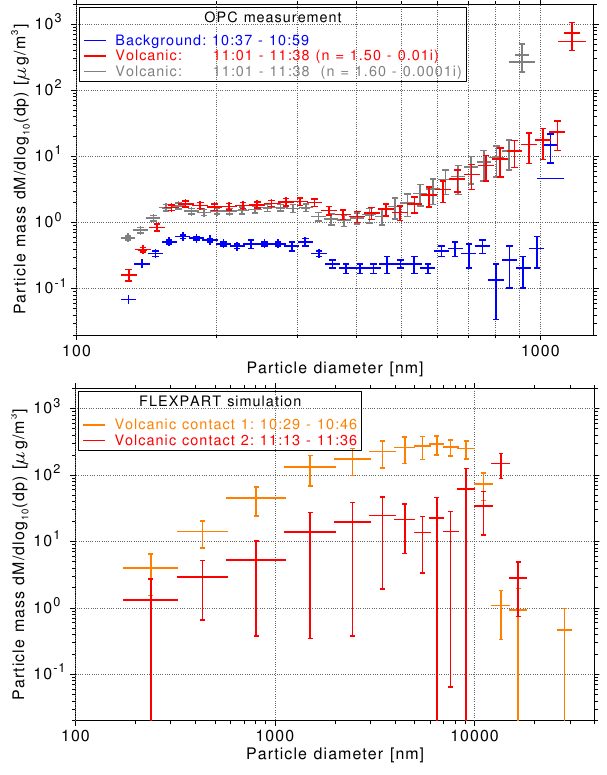
Fig. 8. Measured and modelled particle mass size distributions for the CARIBIC flight on 19 May 2010. Upper panel: measured OPC size distributions. Shown are averaged distributions for the back- ground aerosols (blue) and for the volcanic ash cloud (red & gray). Error bars indicate the 1- σ variability for the two periods. The solid bars show the mass calculated with the smallest slope for the size distribution extrapolation. The long bars at the uppermost size channel show the derived mass if the largest slope is used in the extrapolation. Lower panel: ash particle size distributions from the FLEXPART simulations averaged over the first predicted ash cloud encounter (orange, not observed with the OPC) and the second ash encounter (red, confirmed by the OPC measurements). Note the different